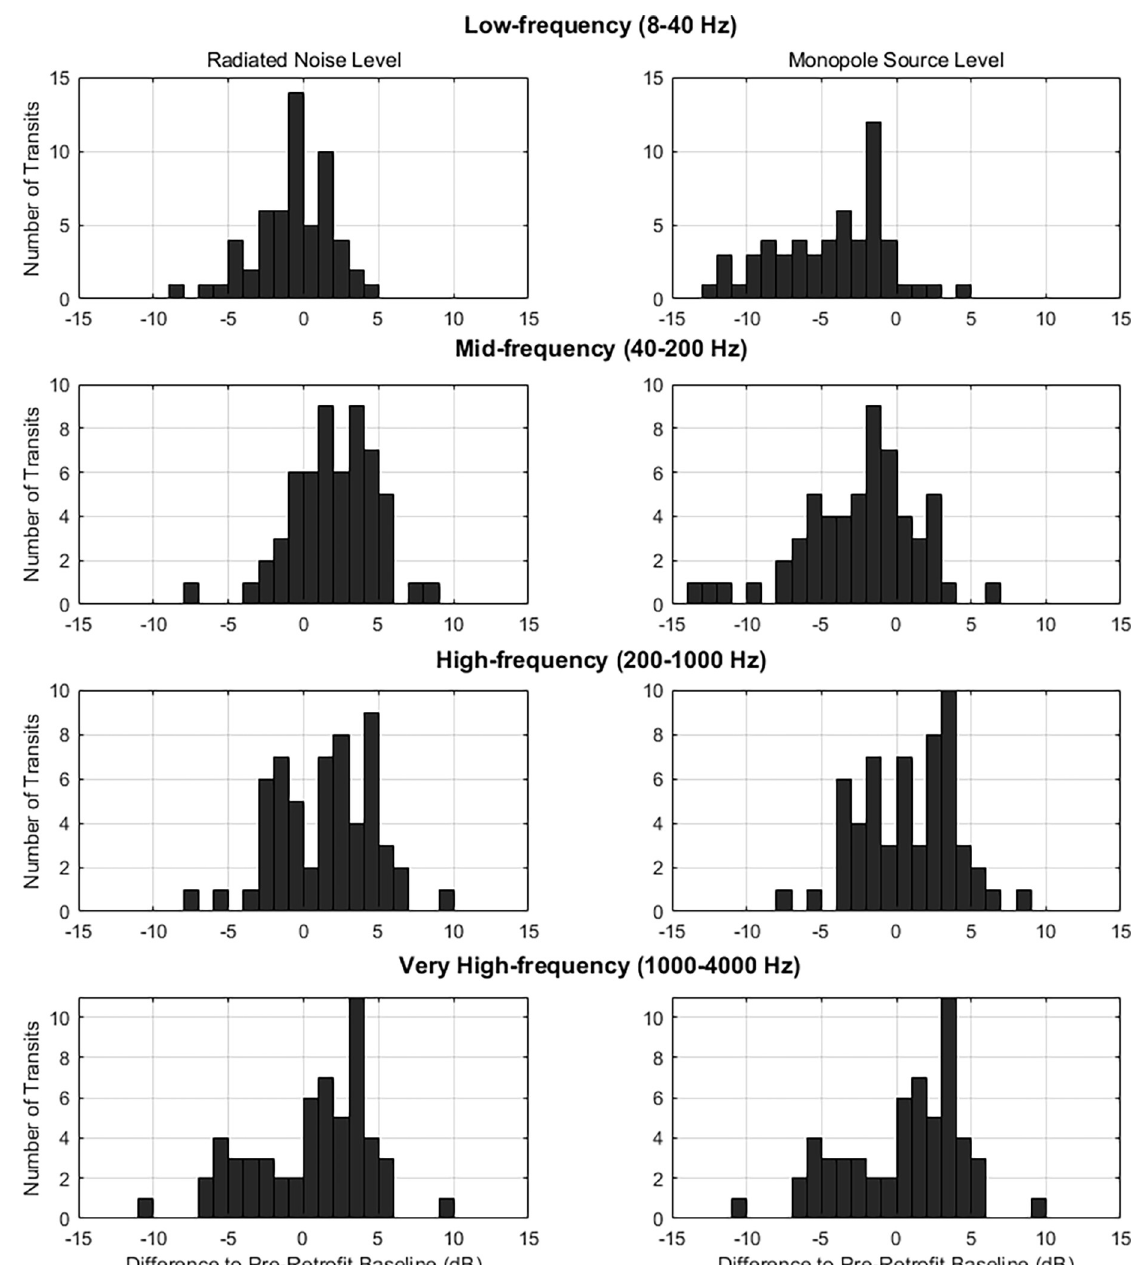
Fig 6. Differences in dB pre- and post- retrofit. Differences in dB between the pre- and post-retrofit radiated noise level (left), and monopole source level (right) for low-, mid-, high-, and very high-frequency